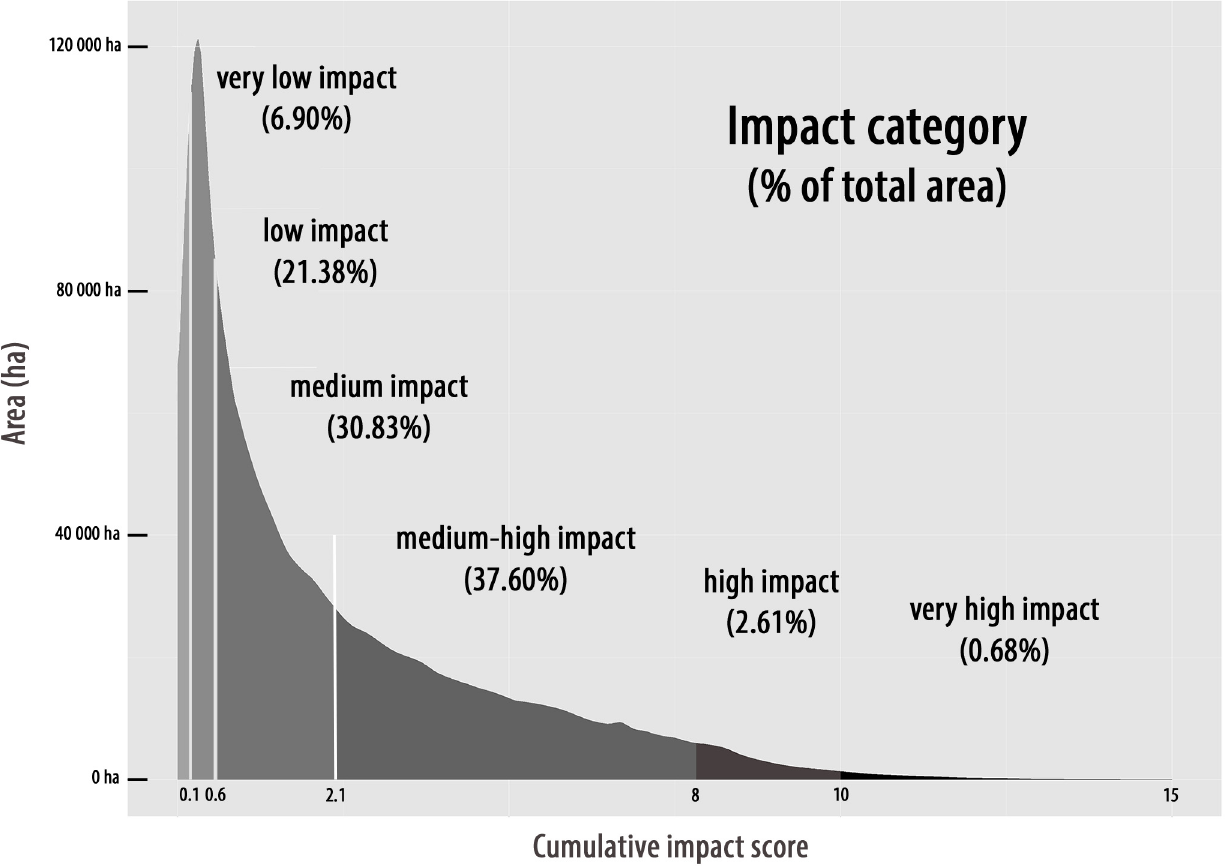
Fig 3. Cumulative impact scores ( I C ) depicting the area (in ha) and the percent of total area (in parentheses) that falls within each impact category.